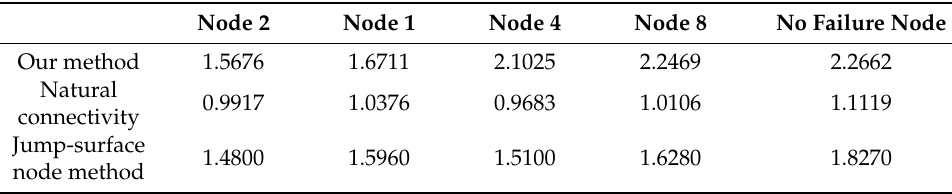
Table 6. Invulnerability index when nodes fail in